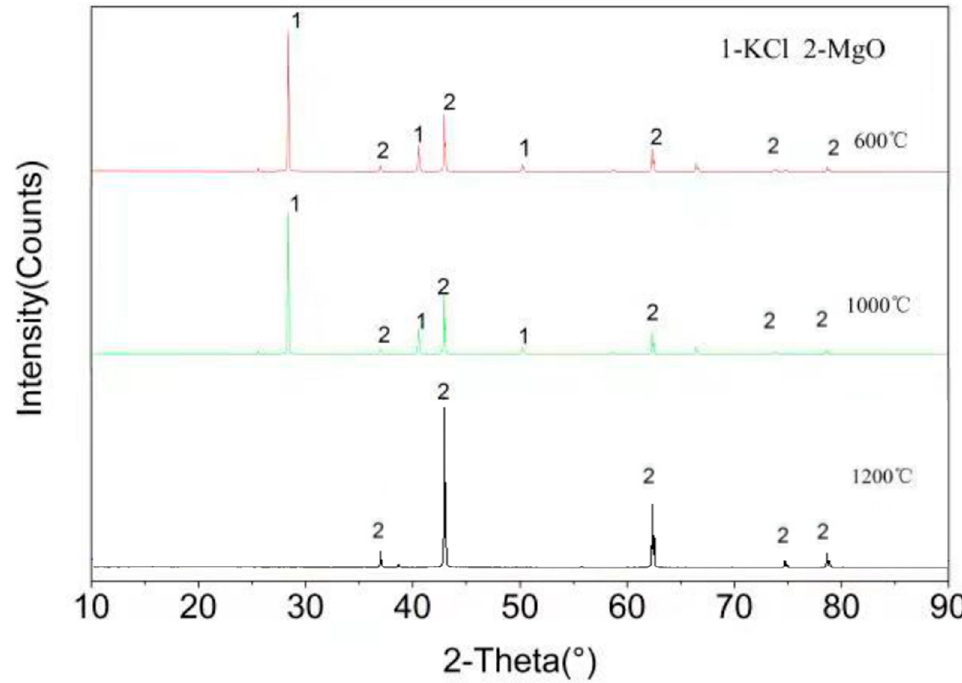
Figure 4. XRD patterns of the products of the reaction between MgO and KCl.